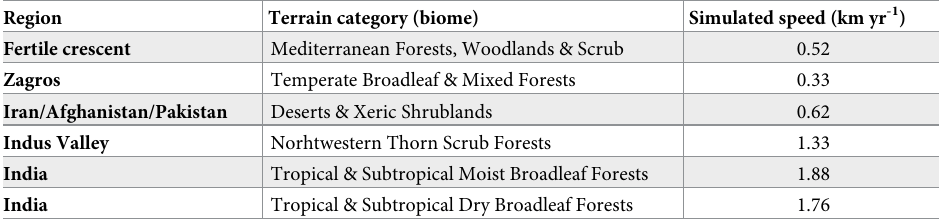
Table 2. Simulated speeds in the main biomes of the study area as selected by the genetic algorithm.